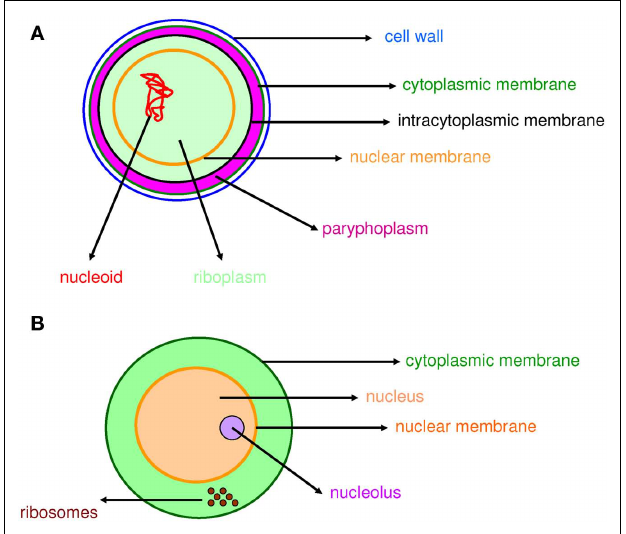
FIGURE 1 | Compartmentation in prokaryotes and eukaryotes. Compartmentation of Gemmata obscuriglobus (A) and a eukaryotic cell (B) is comparable.